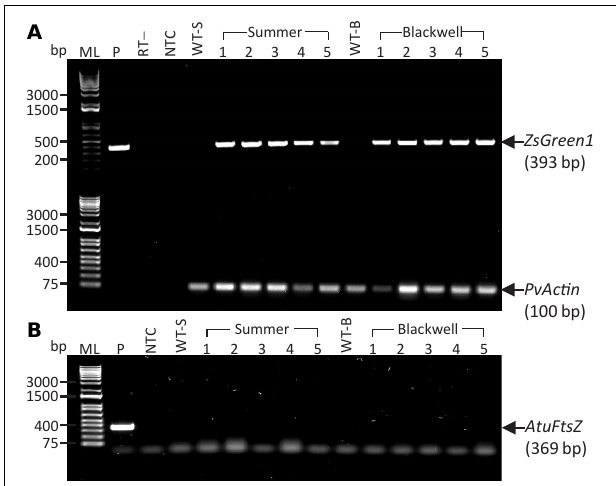
FIGURE 4 | Detection of transgene expression and the presence of remnant Agrobacterium cells in putative transgenic plants. (A) RT-PCR results for the ZsGreen1 gene with a target fragment size of 393 bp (top panel) in five putative transgenic plants of the upland switchgrass cultivars ‘Summer’ (S1–S5) and ‘Blackwell’ (B1–B5). The PvActin gene with a target fragment of 100 bp (bottom panel) was used as an internal control. P, plasmid DNA of PHP93739 as positive control; RT-, reverse transcriptase minus as negative control. (B) PCR results for the LBA4404 chromosomal gene, AtuFtsZ , in the same sets of plants as in panel A . P, the target fragment of 369 bp for the AtuFtsZ gene amplified with chromosomal DNA from LBA4404 as the template. Faint bands in panel B are primer dimers. ML, 1 kb molecular ladder; NTC, No template control; WT-S, Summer wild type plant; WT-B, Blackwell wild type plant. DNA samples for S1–S5 and B1–B5 were identical to S1–S5 and B1–B5 used in Figure 3